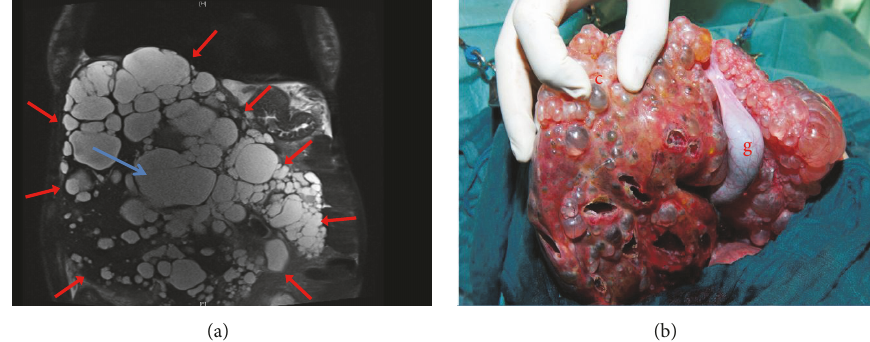
Figure 3: Well-perfused liver cysts (blue arrows) are highlighted by contrast medium (liver size marked with red arrows, preoperative computed tomography scan, early venous phase). Explanted cyst liver (b): gall bladder, g; cysts,